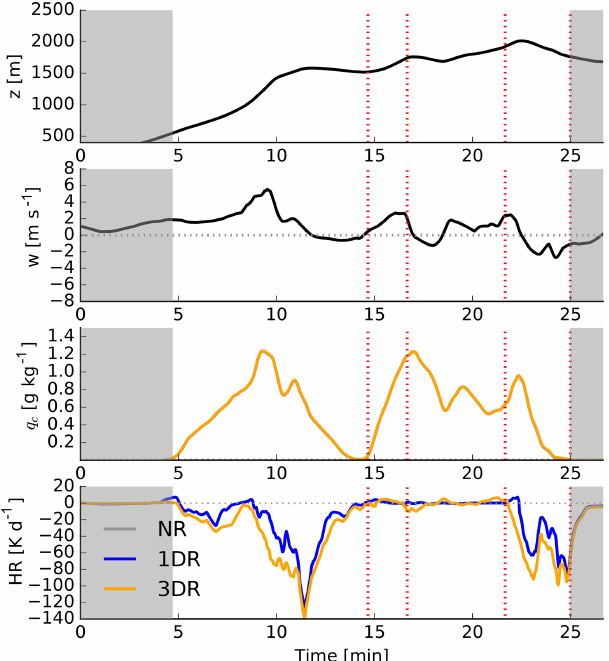
Figure 5. Time series of different properties of the first selected parcel. Shown are height, vertical velocity, q c , heating or cooling rate, predominant radius and the heating or cooling rate per droplet. Gray areas show time intervals where the q c is below 0.01gkg − 1 . The red dotted lines show selected time steps used in the following